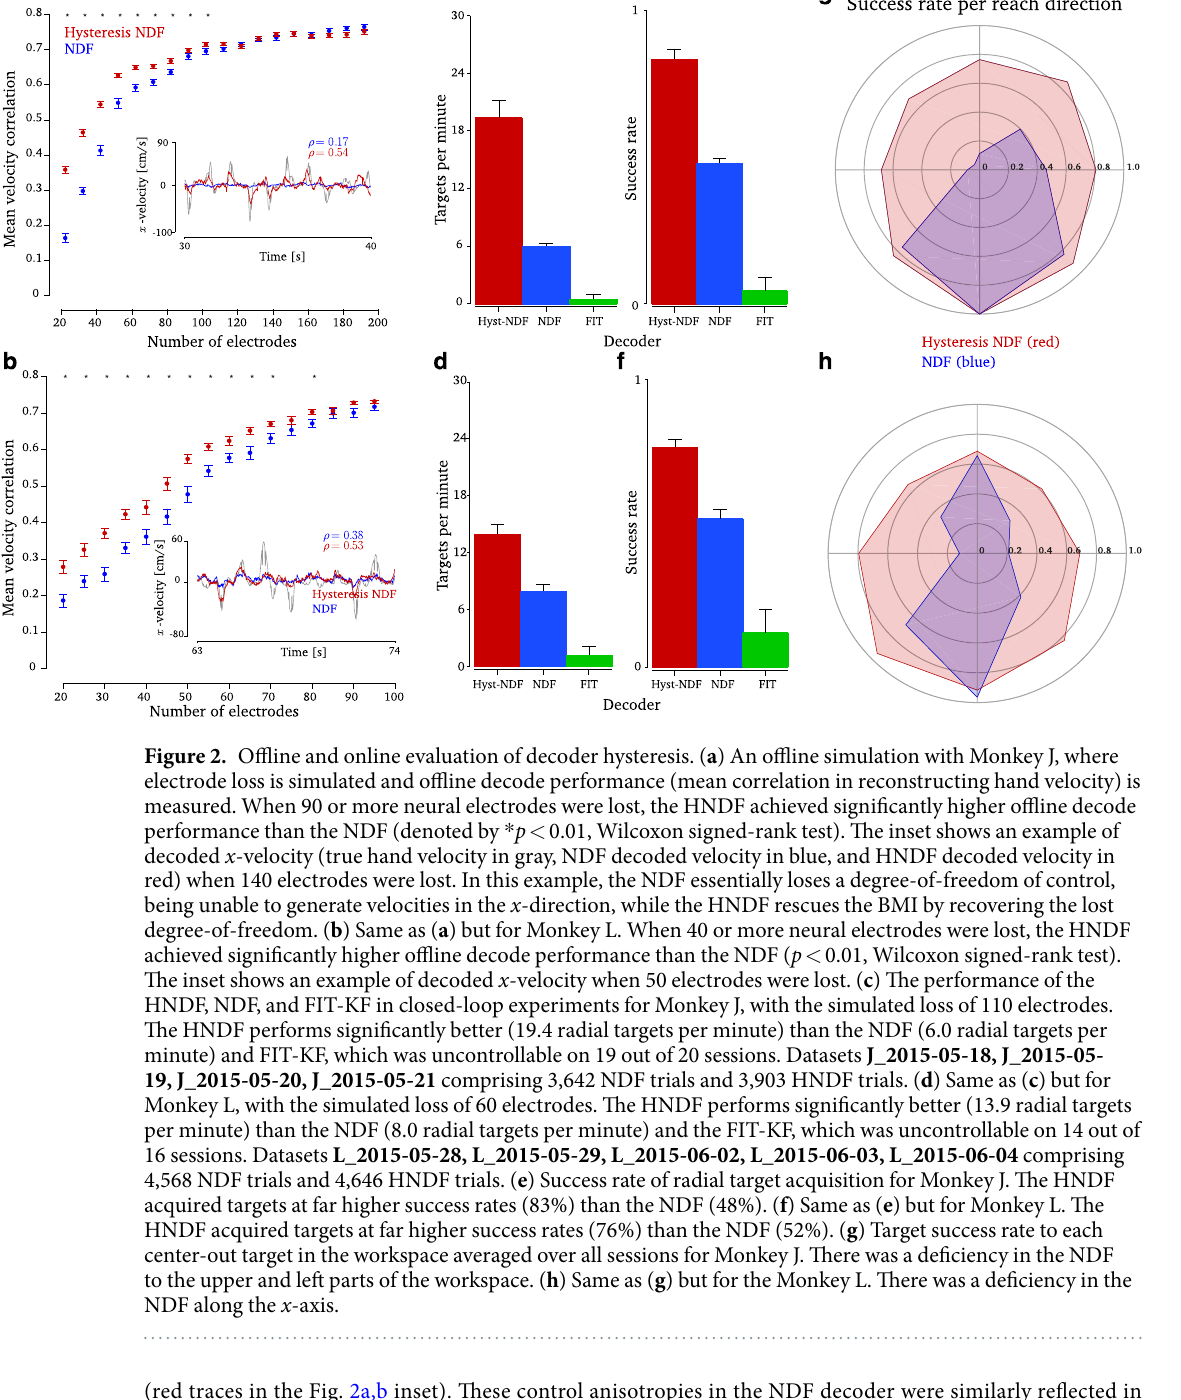
5 ScieNtific REPORts | 7: 7395 | DOI:10.1038/s41598-017-06029-x